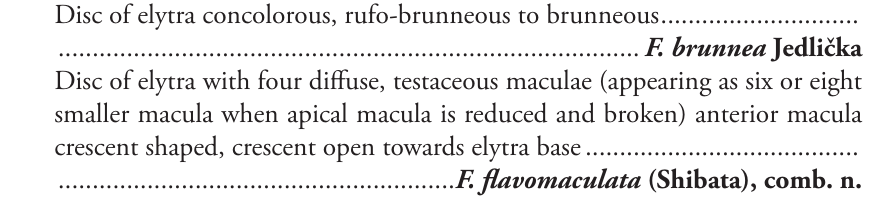
Key to the Taiwanese species of the genus Formosiella Jedlička Disc of elytra concolorous, rufo-brunneous to brunneous